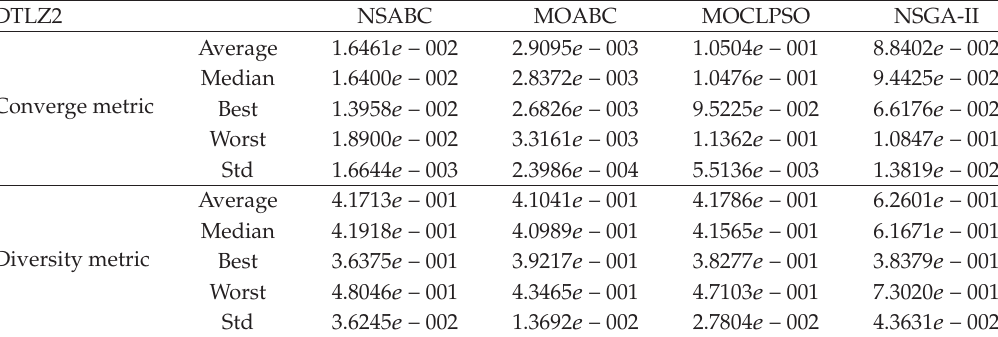
Table 18: Comparison of performance on DTLZ2 after 20000 FEs.